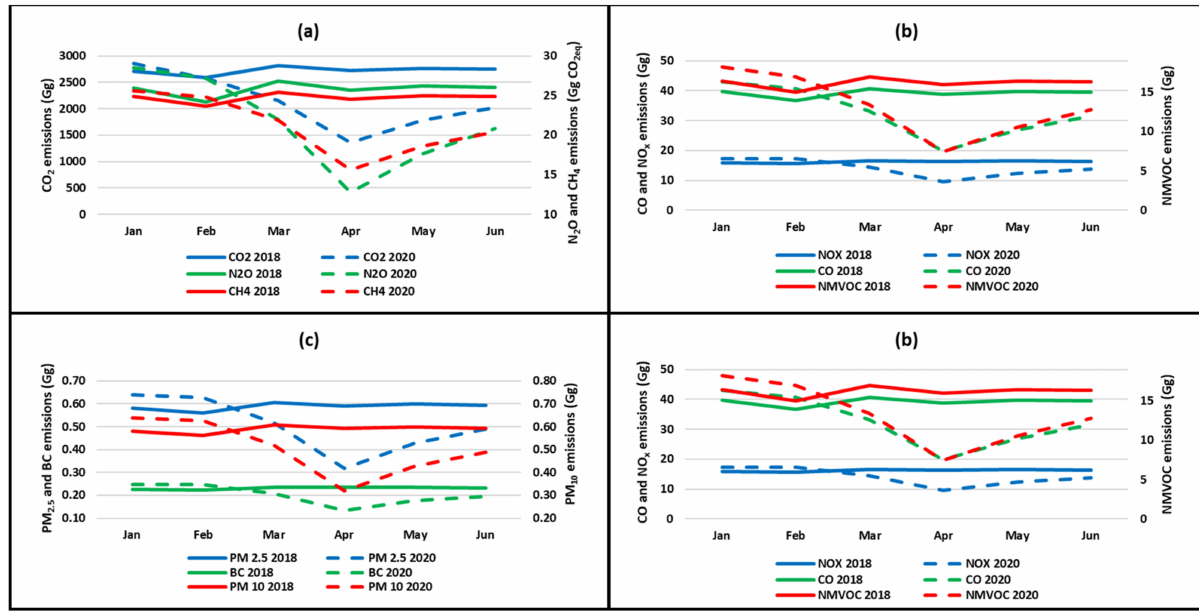
Figure 2. Estimated total emissions (Gg) of the four groups of pollutants that affect climate change, air quality and health: ( a ) GHGs (CH 4 , CO 2 and N 2 O); ( b ) ozone precursors (CO, NMCOV and NOx); ( c ) aerosols (BC, PM 10 and PM 2.5 ); ( d ) acidifying gases (NH 3 and SO 2 ) for January to June of 2018 and